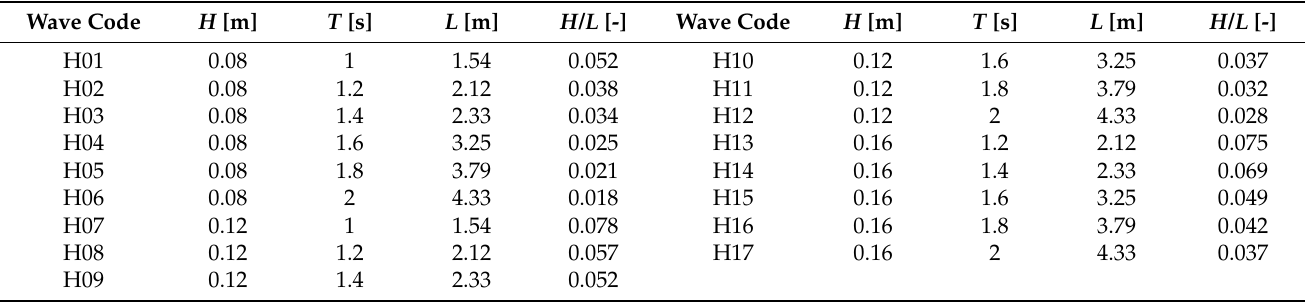
Table 2. Regular wave conditions tested (values at laboratory scale 1:25).